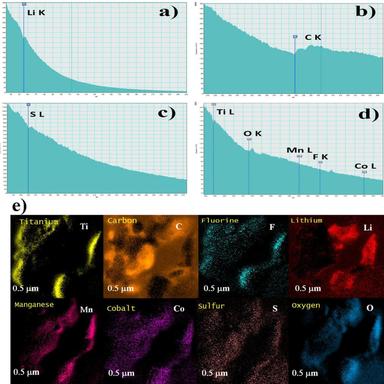
EELS spectra of (a) LiAK, (b) CAK, (c) SAL and (d) TiAL, OAK, MnAL, FAK, and CoAL in hybrid MCS-MXene (1:2); (e) STEM images of all elements present in hybrid MCS-MXene (1:2).